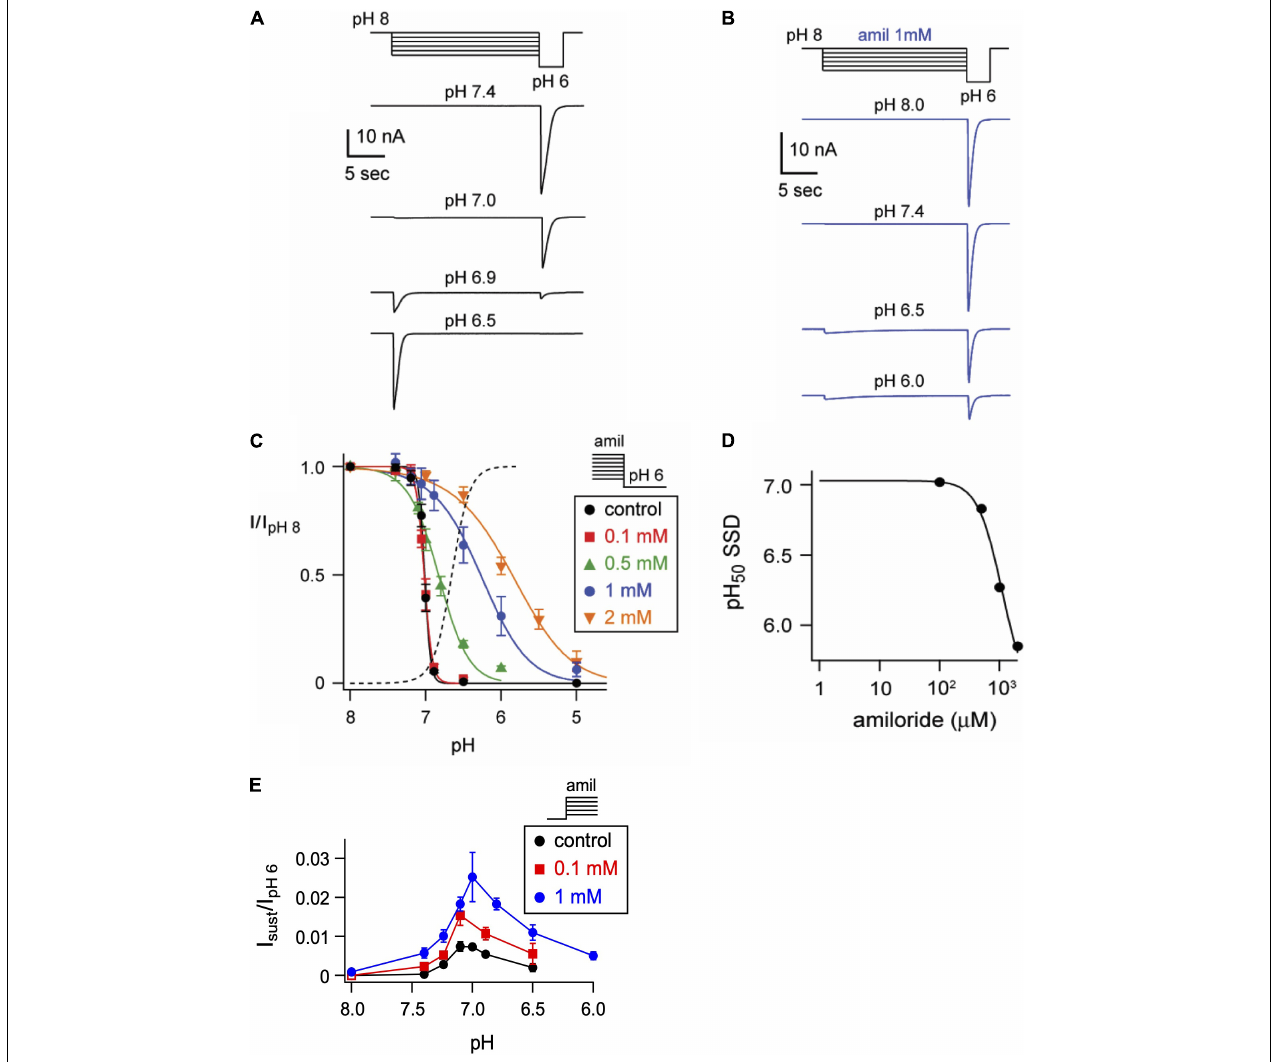
FIGURE 3 | Amiloride inhibits the pH-dependent steady-state desensitization of ASIC3. (A) Representative ASIC3 currents evoked by stepping from pH 8 to the indicated desensitizing pH application for 20 s, following by a pH 6 test application. (B) Currents were recorded as in A , except the desensitizing 20 s pH solutions contained 1 mM amiloride. (C) pH dose-response curves for steady-state desensitization (SSD) recorded as in A, in control (no amiloride) and the indicated amiloride concentration solutions normalized to the currents evoked by stepping from pH 8 to pH 6 ( n = 3–10 per data point). Lines are fits of the Hill equation (pH 50 = 7.0, 7.0, 6.8, 6.3, and 5.9 for 0, 0.1, 0.5, 1, and 2 mM amiloride, respectively). Dashed line is fit of Hill equation for dose-response of pH activation in absence of amiloride from Figure 2E . (D) A plot of the amiloride dose-response on the pH 50 values of steady-state desensitization measured from data in C . Line is fit of Hill equation (EC 50 = 1.1 mM). (E) pH dose-response for activation of sustained currents (measured at the end of 10 s pH application) in 0 mM (control), 0.1, and 1 mM amiloride. Data are acquired by stepping from pH 8.0 (with 0 mM amiloride) to the indicated test solutions (containing the indicated amiloride concentrations) and are normalized to the peak currents (transient) evoked by pH 6.0 in no amiloride ( n = 4–10 per data